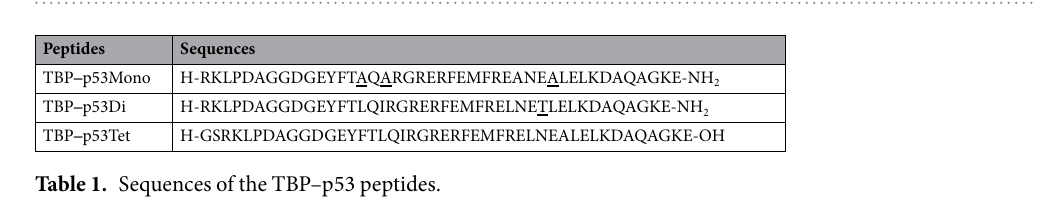
Table 1. Sequences of the TBP–p53